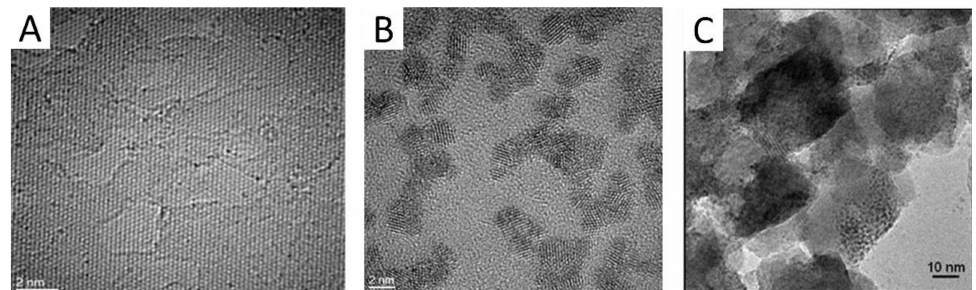
Figure 3. ( A ) Exfoliated graphite yielding pristine graphene and ( B , C ) adhesion of Ir oxoparticles adhered to electrochemically exfoliated graphene nanoparticles, eG (( A , B ) HRTEM, ( C ) SEM). (Note that Iridium species evolve under the